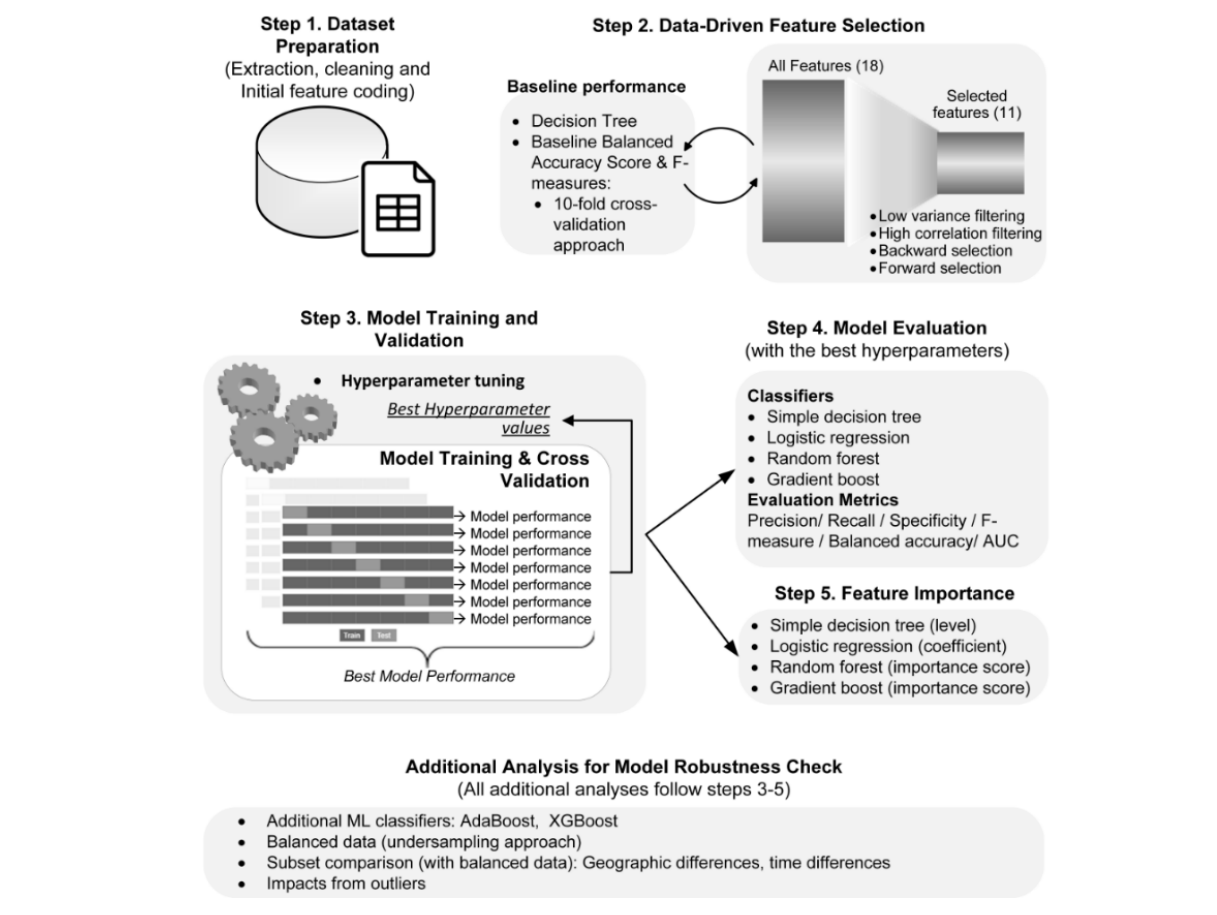
Figure 1. Analysis pipeline. AUC: area under the receiver operating characteristic curve; ML: machine